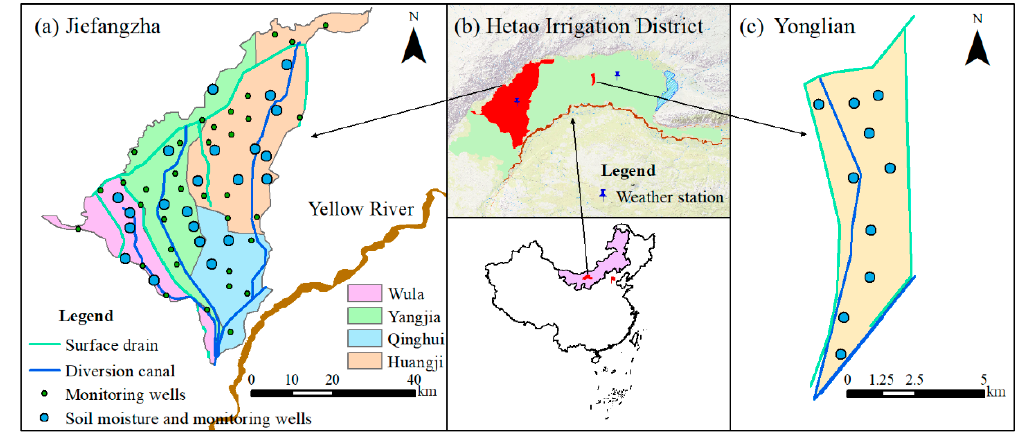
Figure 1. The location of the two study areas and the monitoring sites.